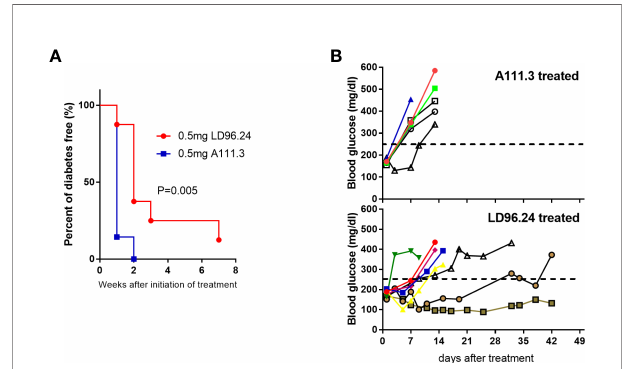
FIGURE 8 | Treatment of NOD mice with LD96.24 delays progression to T1D. Groups of 12-week-old female NOD mice were monitored for blood glucose until they were over 170 mg/mL. Then, they were treated weekly with 0.5 mg LD96.24 (n=8) or 0.5 mg A111.3 (n=7) until the animals reached 23 weeks of age. (A) Blood glucose levels of individual mice receiving IgG2a isotype control antibody A111.3 (upper) or LD96.24 (lower). (B) Percentages of diabetic-free mice after LD96.24 and A111.3 antibody treatment. P-values were determined by using the c 2 log-rank